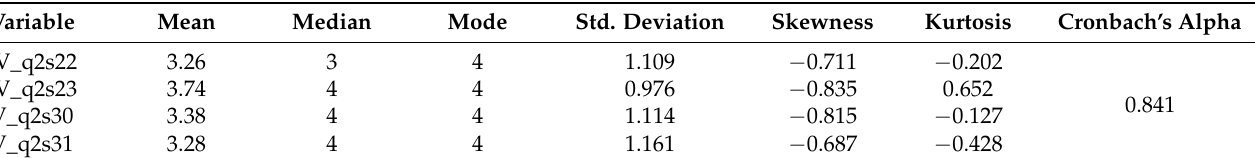
Table 4. Technological capabilities and descriptive statistics from the survey responses.